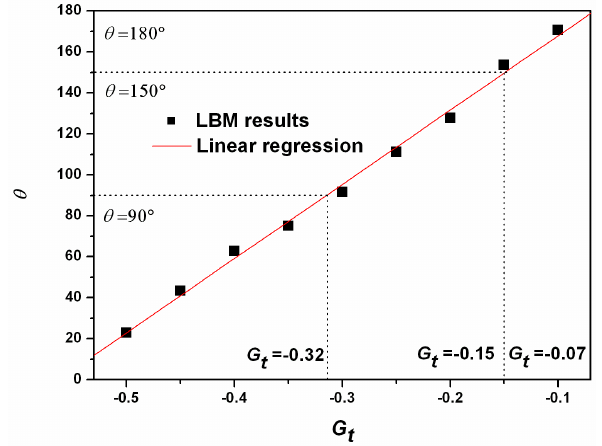
Figure 4. Relationship between static contact angle  and fluid/solid interaction parameter G in the case of 6.0  t